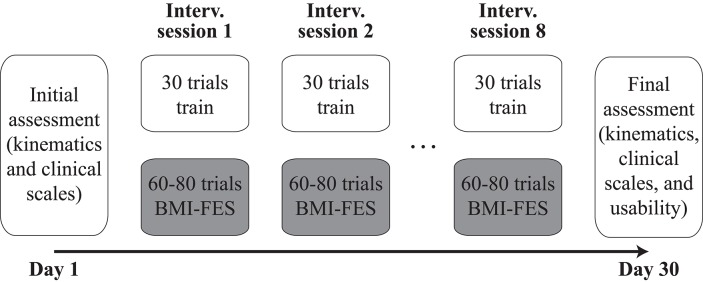
Structure of the intervention carried out with each patient.